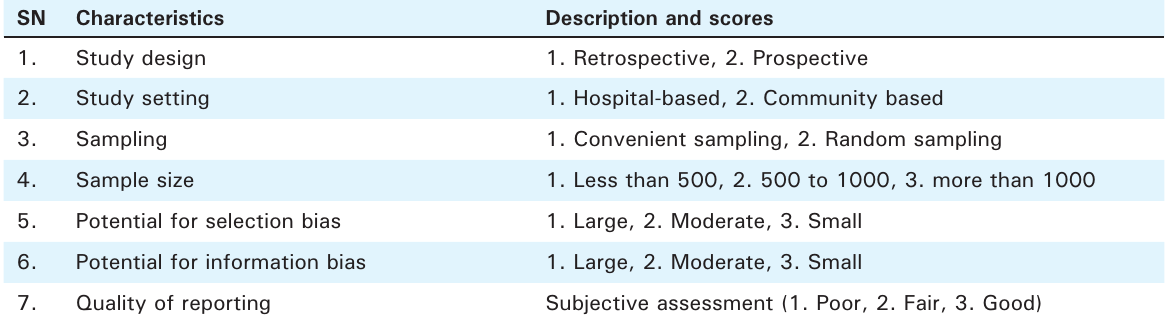
Table 1. Quality assessment